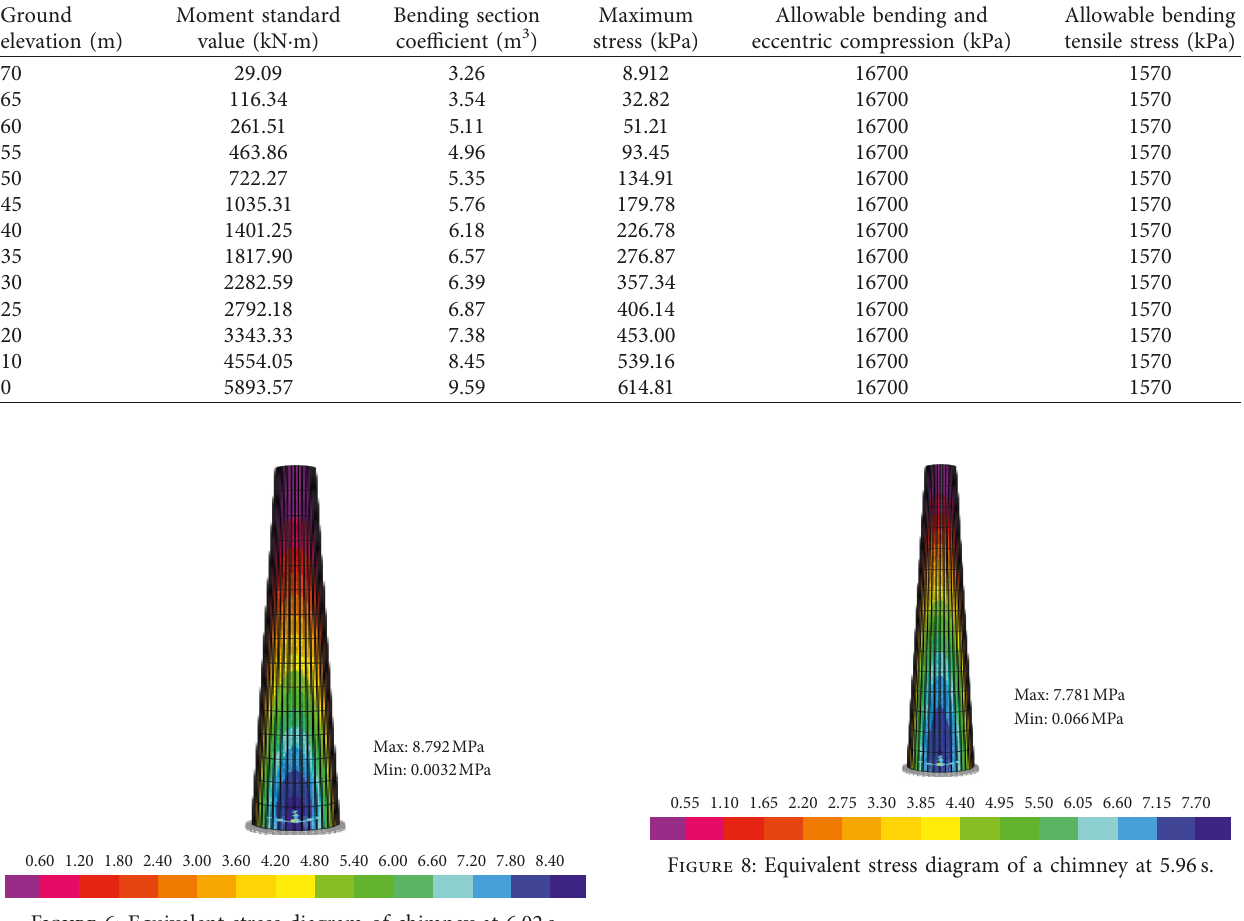
Figure 6: Equivalent stress diagram of chimney at 6.02 s.